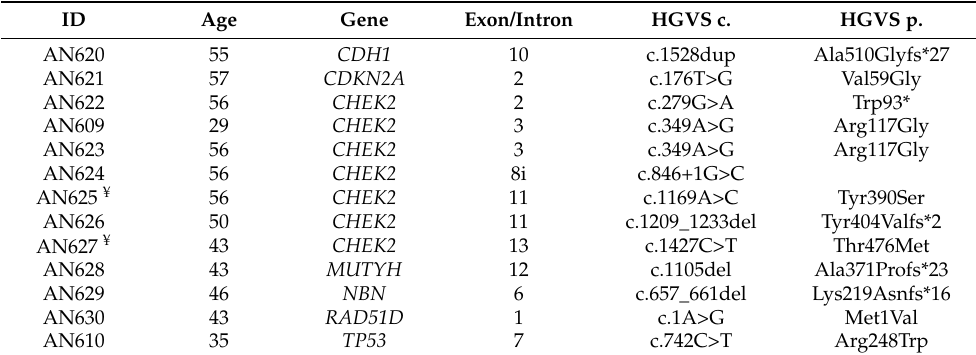
Table 2. Non- BRCA likely pathogenic/pathogenic variants in 255 women with a breast cancer diagnosis analyzed by a panel of genes.